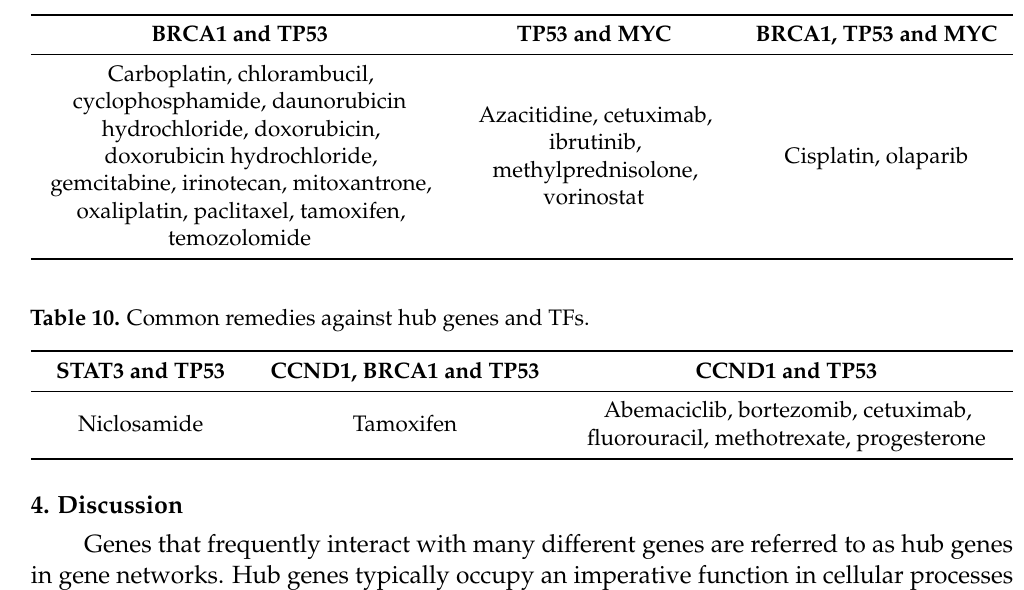
Table 9. Common remedies against multiple TFs.